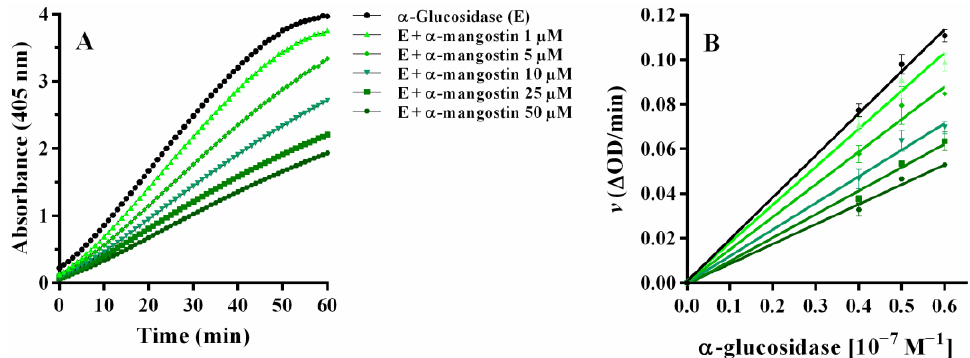
Figure 5. Kinetics of 0.04 μM α - glucosidase in the presence of increasing concentrations of α -mangostin ( A ). The plot “ v versus [ α -glucosidase]” is reported ( B ). Concentration of pNPG substrate: 2 mM. Data are reported as mean ± SEM of 3–6 experiments.